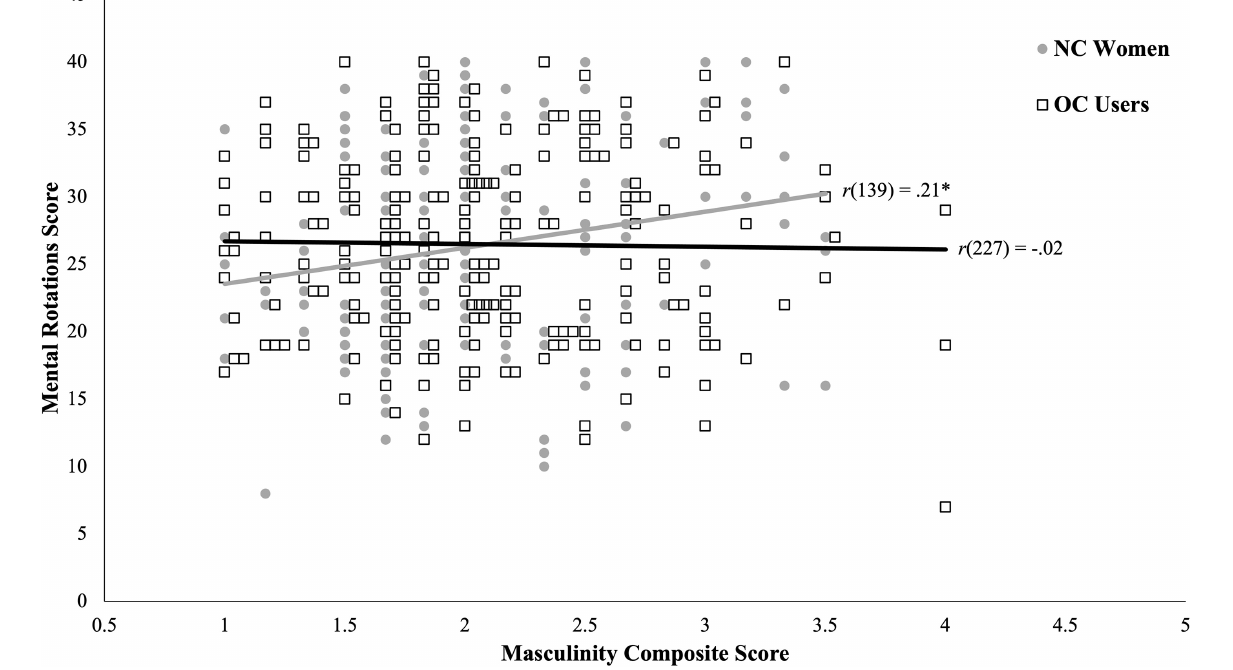
FIGURE 1 | Relation between masculinity and spatial skills (operationalized by three-dimensional mental rotations skill) plotted by hormonal milieu (operationalized by NC vs. OC status). Gray circles and black squares show individual data points of NC women and OC users, respectively, with like-colored lines reflecting the linear trends for each group (i.e., zero-order correlations). NC, naturally cycling; OC, oral contraceptive. ∗ p < 0.05.